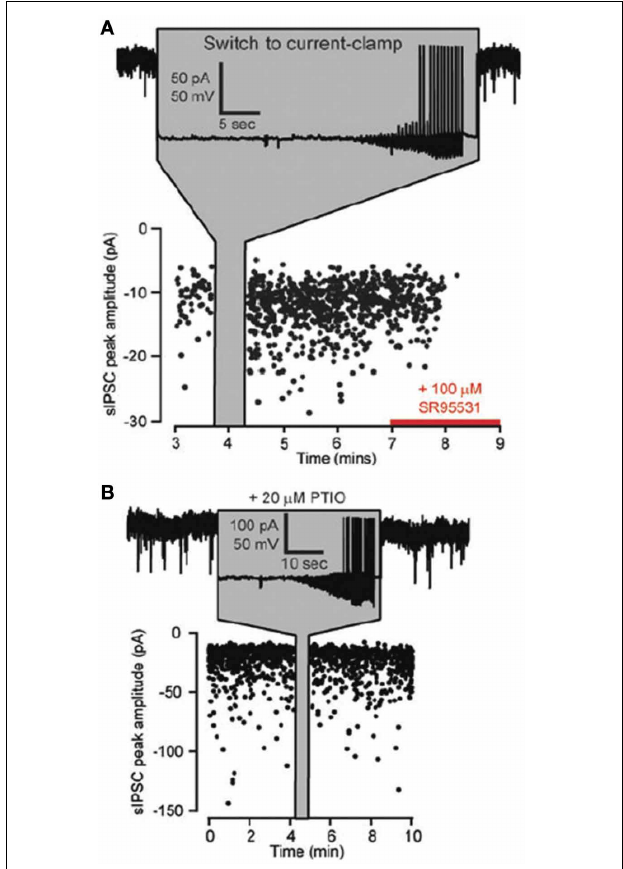
FIGURE 7 | Effects of NO on the frequency of GABAergic spontaneous IPSCs (sIPSCs). (A) Plot of the peak amplitudes of spontaneous IPSCs against time for a thalamocortical (TC) lateral geniculate neuron. At the time indicated by the gray panel a switch is made from voltage to current clamp so that somatic action potentials can be generated. Note the increase in sIPSCs on returning to voltage clamp and the block of all sIPSCs by SR95531 toward the end of the experiment. (B) A similar recording from a TC relay neuron with the same protocol as in (A) , but in the presence of the NO scavenger PTIO (20 μ M) in the external solution. Note that GABAergic synaptic plasticity is blocked. Adapted from Bright and Brickley (2008) with kind permission of the authors and the Physiological